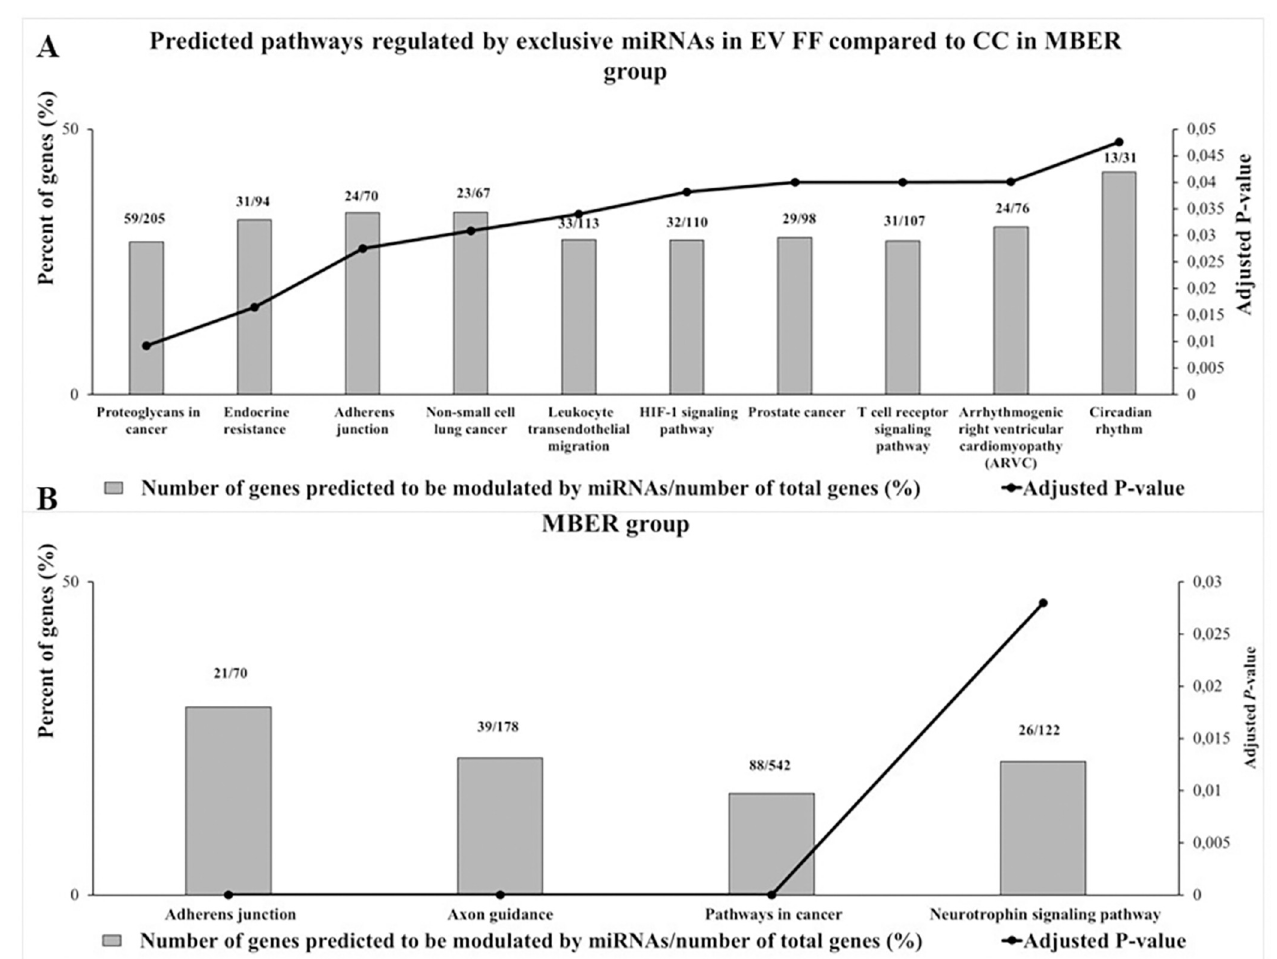
Fig 6. Enrichment analysis performed in miRWalk 3.0 software of predicted pathways modulated by exclusives or up-regulated miRNAs of cumulus cells (CC) and follicular fluid extracellular vesicles (EV FF) from 3–6 mm follicles from cows with moderated body energy reserve (MBER). A. The 10 predicted pathways with highest percent of genes predicted to be modulated by exclusives miRNAs in EV FF compared to CC in MBER group. B. The predicted pathways modulated by miRNAs up regulated in CC compared to EV FF in MBER group. The Y-axis in left represents the percent of genes (%) predicted to be modulated by miRNAs and the Y-axis in right shows the adjusted P -value (Adjusted P -value <